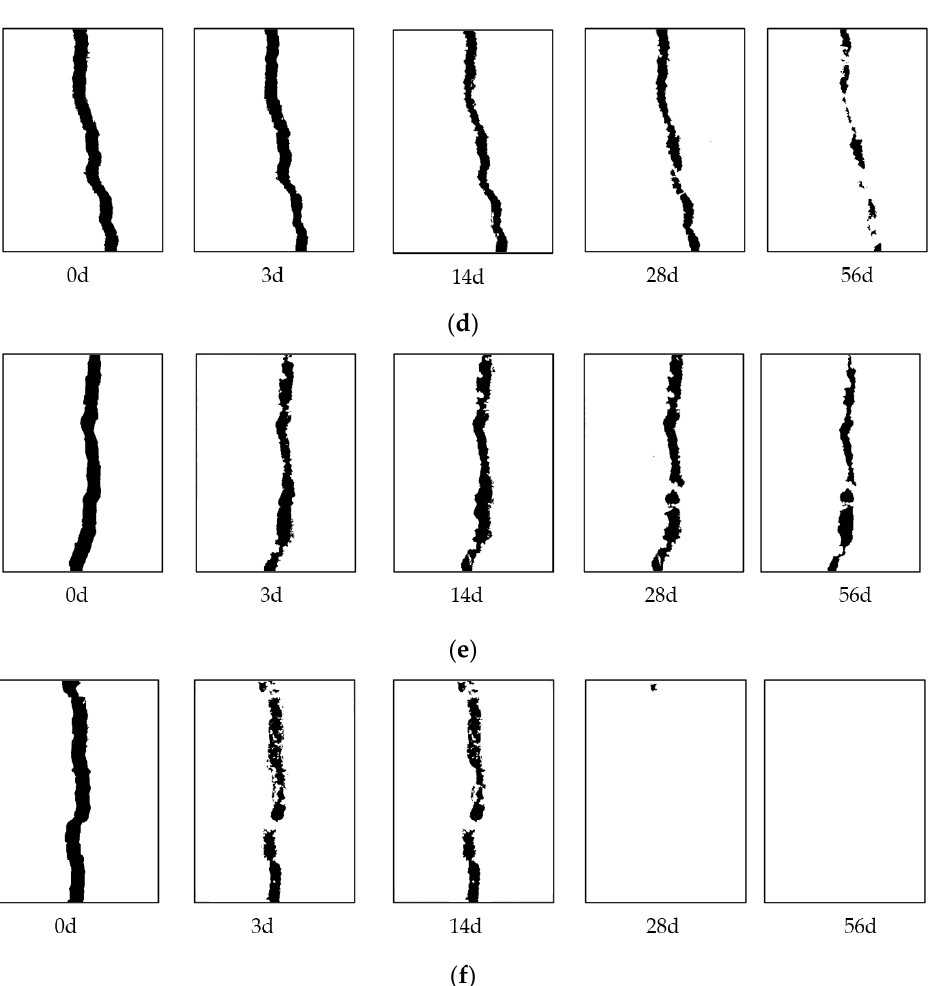
Figure 3. Binarized self-healing images of surface cracks in mortars under different exposure environments. ( a ) The control mortar specimens under the standard curing. ( b ) Mortar specimens with bacteria under the standard curing. ( c ) The control mortar specimens under the dry – wet cycle curing. ( d ) Mortar specimens with bacteria under the dry – wet cycle curing. ( e ) The control mortar specimens under the water curing. ( f ) Mortar specimens with bacteria under the water curing.